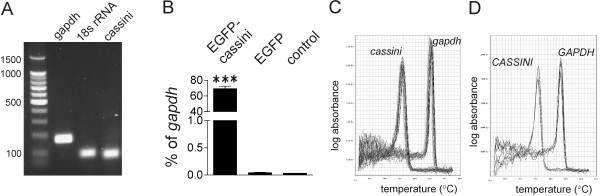
Primer integrity and specificity analysis. (A) 2% agarose gel electrophoresis of control 8093 RT/PCR products using gapdh, 18 s rRNA, and cassini shows a single band for each target gene. (B) Real time RT/PCR on RNA isolated from non-transfected MEFs (control), MEFs transfected with an EGFP-cassini construct or with empty EGFP-C1 plasmid. Values (mean ± SD of triplicate real-time PCR) are expressed as percent of gapdh. (C, D) Derivative dissociation curves from real-time RT/PCR on mouse (C) and human (D) RNA confirm single product amplification. The cassini amplicon shows a single peak for both murine and human RNA with a Tm of ~76°C. Gapdh primers peak at Tm ~85.5°C. ***p < 0.001 EGFP-cassini compared to EGFP-C1 and control.